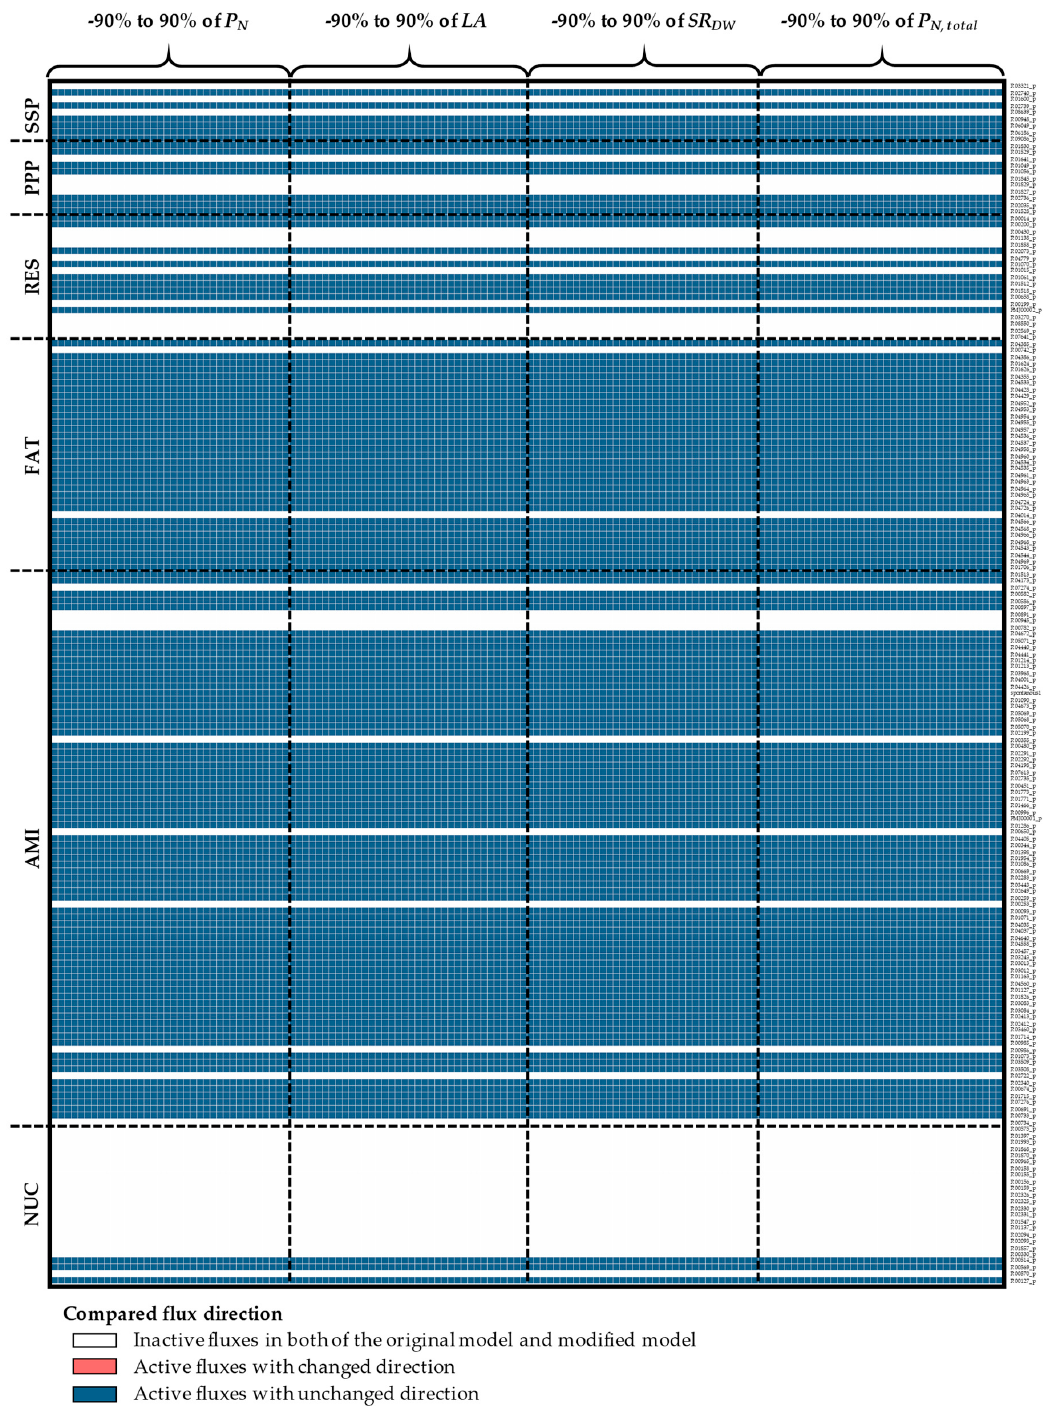
Figure A4. The sensitivity of the plastidial reaction flux direction to variations in the sucrose uptake rate-related data. Inactive reactions containing zero fluxes are denoted by white-colored grids. Active reactions, non-zero fluxes, with similar flux direction as the original model are denoted by blue grids; while those with dissimilar flux direction (breakpoint) are denoted by red grids. LA ; total leaf area per plant; P N , photosynthetic rate; P N, total , total photosynthetic rate per plant; SR DW , storage root dry weight per plant; AMI, amino acid biosynthesis pathway; FAT, fatty acid biosynthesis pathway; NUC, nucleotide biosynthesis pathway; PPP, pentose phosphate pathway; RES, respiration pathway; SSP, starch and sucrose biosynthesis pathway.